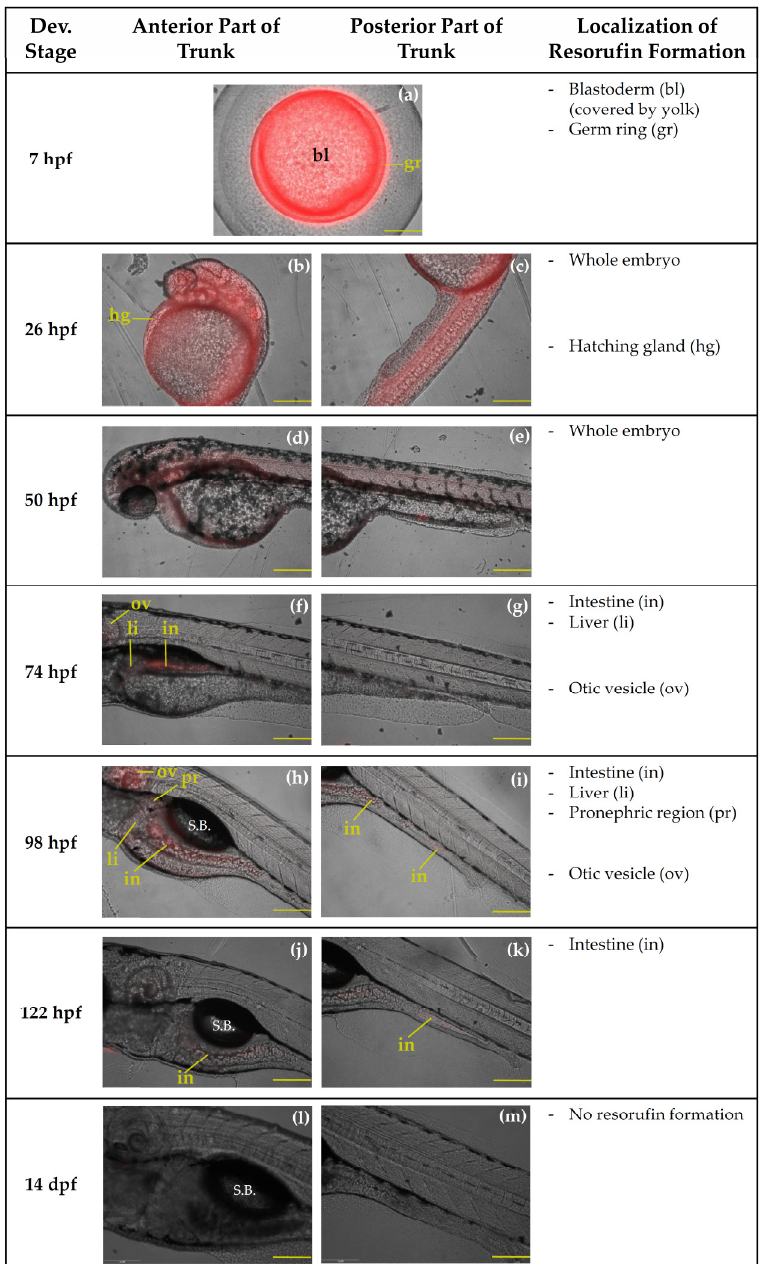
Figure 5. Localization of biotransformation of 7-ethoxyresorufin (ER) in the trunk region of intact zebrafish embryos and larvae at 26 h post-fertilization (hpf) ( b , c ), 50 hpf ( d , e ), 74 hpf ( f , g ), 98 hpf ( h , i ), 122 hpf ( j , k ) and 14 d post-fertilization (dpf) ( l , m ). At 7 hpf ( a ), qualitative analysis of resorufin formation was performed in the whole embryo. The stage of 9 dpf was excluded from the figure since resorufin formation could not be localized due to ventral position of the larvae. Pictures show one embryo/larva out of six used in the study, i.e., three biological replicates with two embryos/larvae per replicate, for each developmental stage. Figure ( a ) shows a vegetal pole view of the embryo. In Figure 5 ( b – m ) lateral views of the anterior and posterior part of the trunk region are shown. The organs in which resorufin had been formed are indicated with a two-letter combination. Since the hatching gland and otic vesicle do not belong to the trunk region, resorufin formation in the respective organs is mentioned separately. S.B.: swim bladder. Scale bar: 200 µ m; ( b , c ): anterior top and dorsal right; ( d – m ): anterior left and dorsal